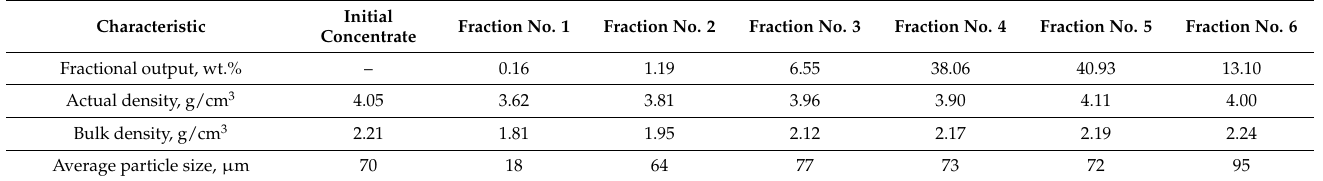
Table 2. Fractional characteristics.